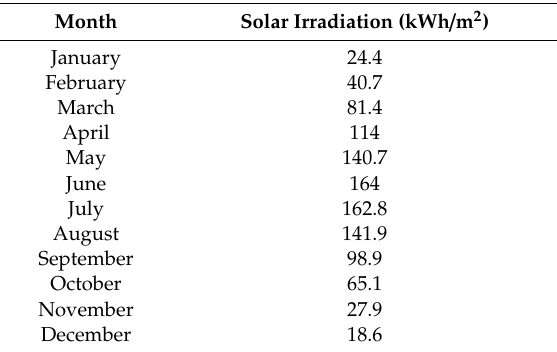
Table 2. Monthly insolation sums for the city of Rzesz ó